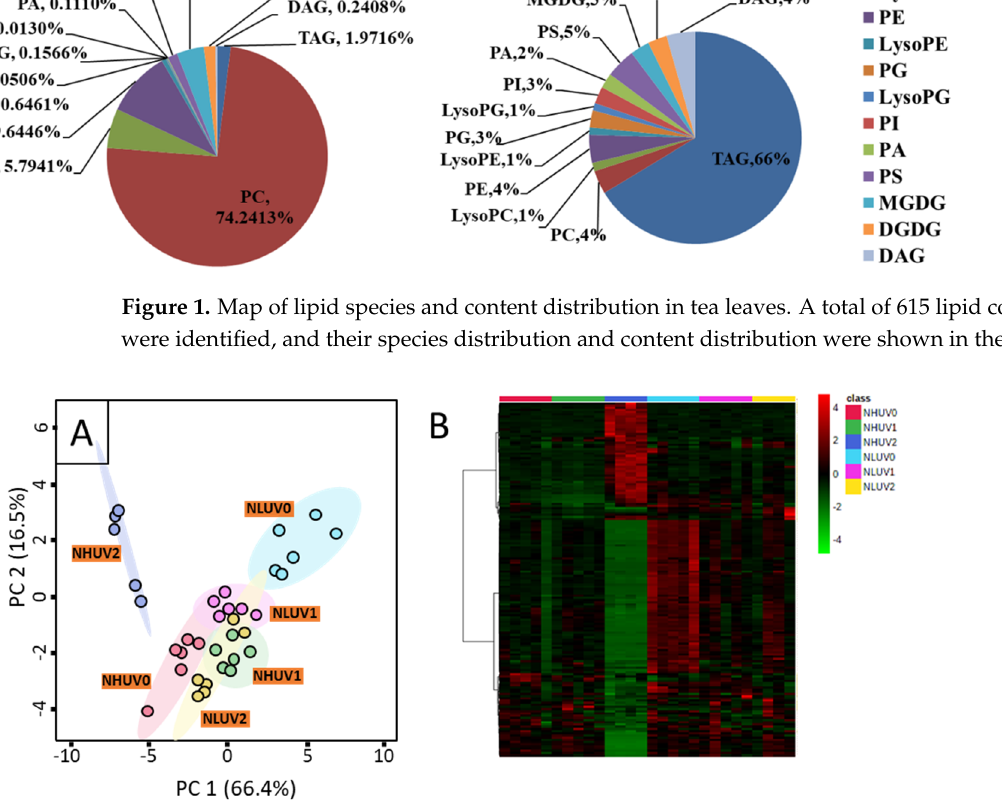
Figure 2. Scores plot of principal component analysis of lipids content in tea leaves ( A ). The dots represent individual samples, and the ellipses represent 95% confidence intervals. Heat map of lipid content changes in tea leaves ( B ). A column represents a set of samples, with each pixel representing a metabolite, in which red represents high concentration and green represents low concentration.